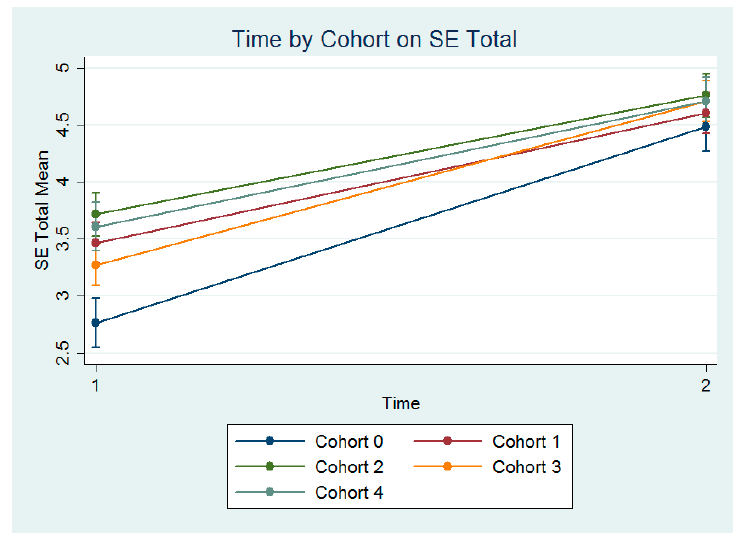
Figure 2. The Effects of Time and Cohort on Self Efficacy (SE) Total Scores.